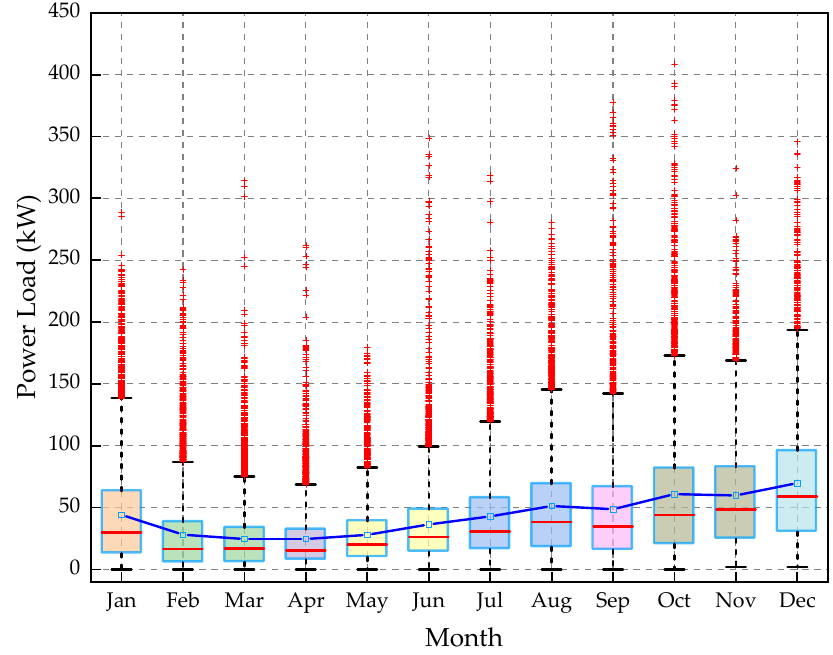
Figure A1. Average electric vehicle charging load per month.